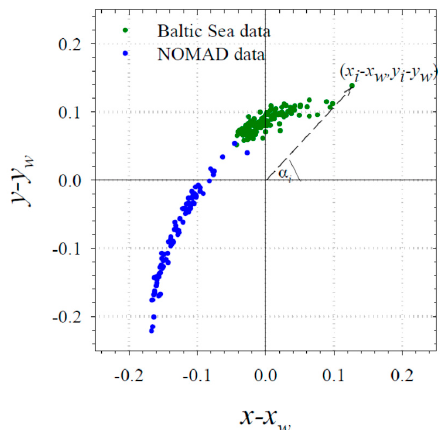
Figure 7. Plot of chromaticity coordinates calculated for data from the Baltic Sea and from the NOMAD database. The example of the hue angle α refers to one of the data points.